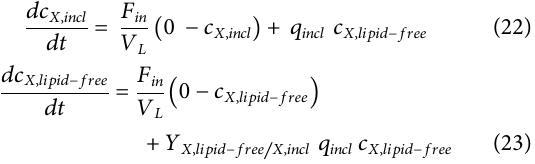
Table 4 . The yield coef fi cients and biomass-speci fi c rates were calculated from our experimental data. For example, biomass yield coef fi cients from glucose Y X/Gluc and from sodium nitrate Y X/NaNO3 were derived from the amount of consumed substrate versus produced biomass using linear regression of process data.